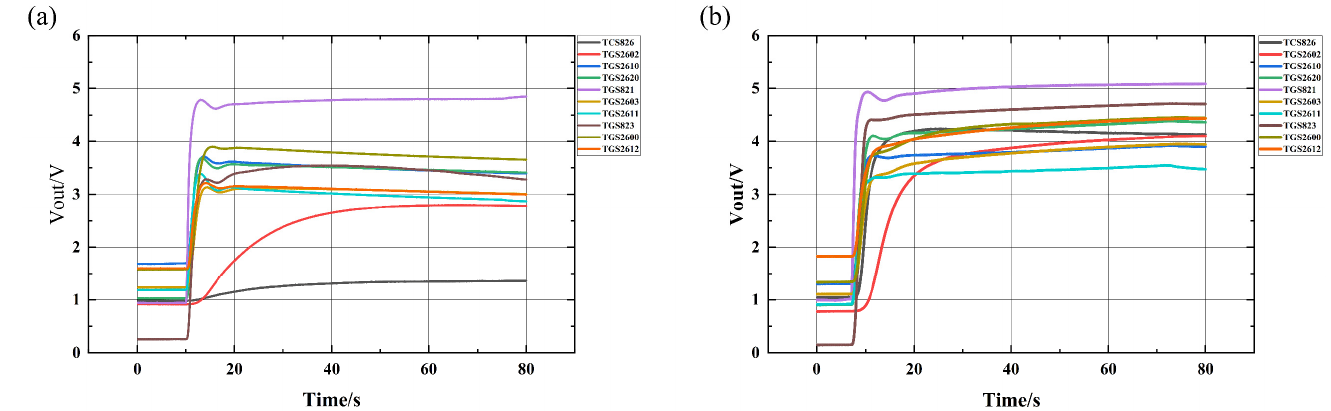
Figure 3. Sensor response curves: ( a ) 0.2 g·kg − 1 soil sample; ( b ) 4.1 g·kg − 1 soil sample.